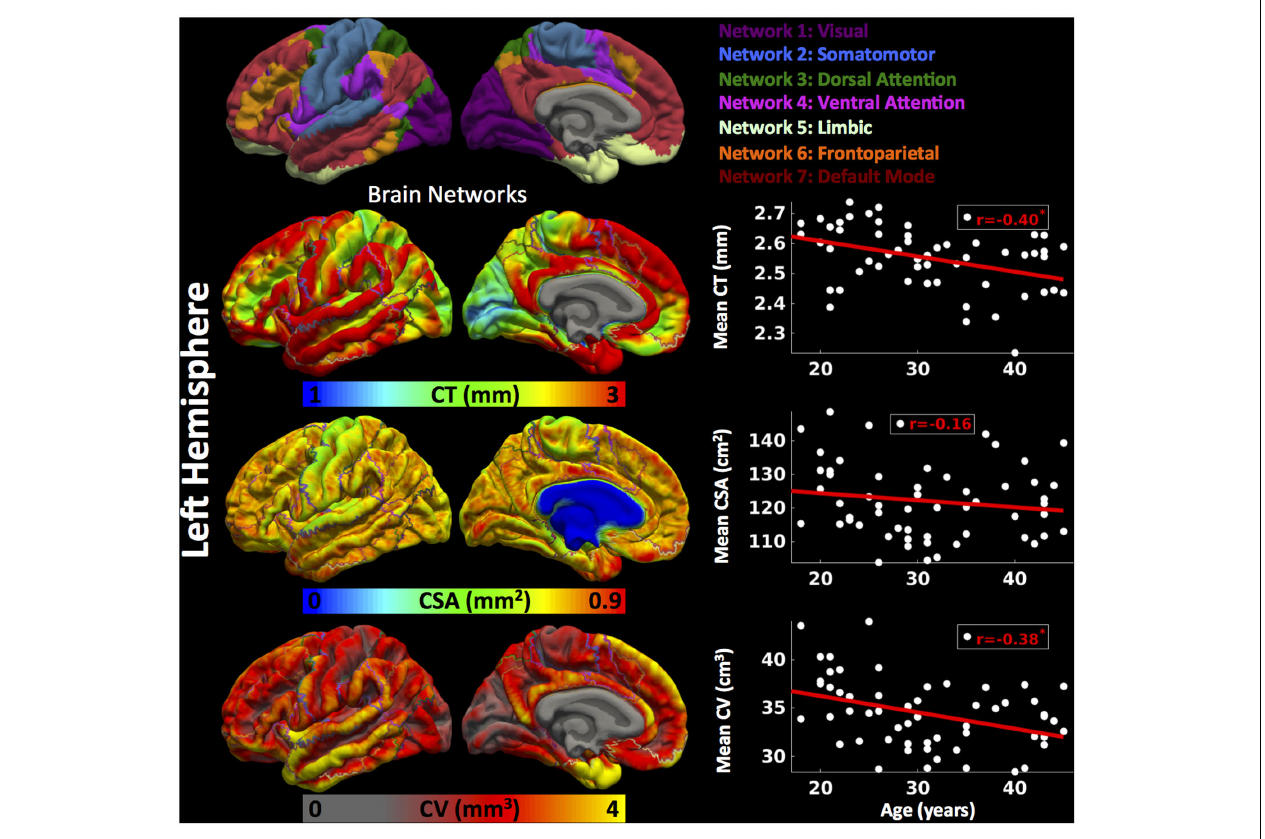
FIGURE 3 | Brain parcellation and age-related changes in mean cortical measures for left hemisphere. Left hemispheric brain parcellation into seven functional networks and vertex-wise maps for cortical thickness (CT in mm), cortical surface area (CSA in mm 2 ) and cortical volume (CV in mm 3 ). Linear plots showing age-related significant reduction in mean CT (in mm), non-significant reduction in mean CSA (cm 2 ) and significant reduction in mean CV (cm 3 ) over left hemisphere.